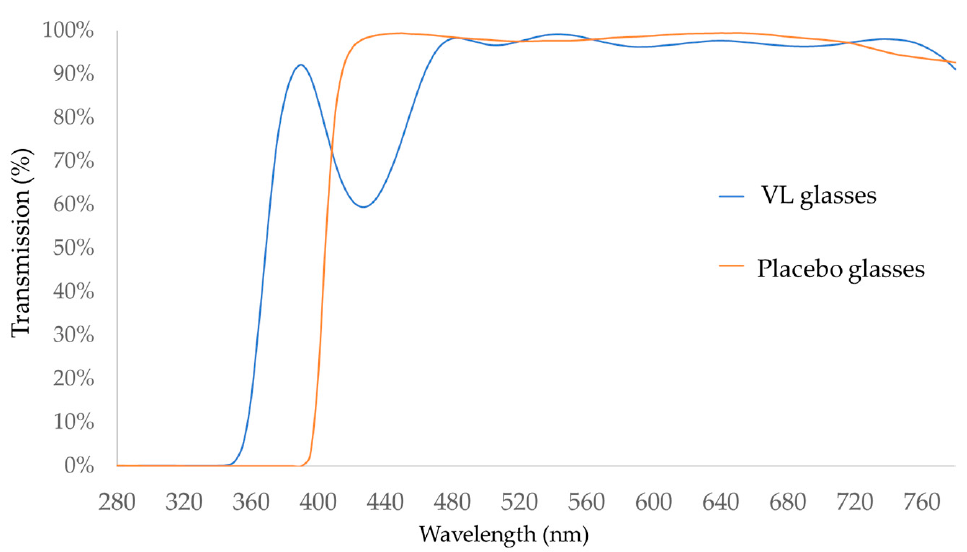
Figure 2. Characteristics of the eyeglasses used in this study: the transmission rate (%) at each wavelength of the light with VL glasses (blue) and with placebo glasses (orange) is shown. VL glasses transmit light 360–400 nm in wavelength, whereas placebo glasses block the light of the wavelengths less than 400 nm.